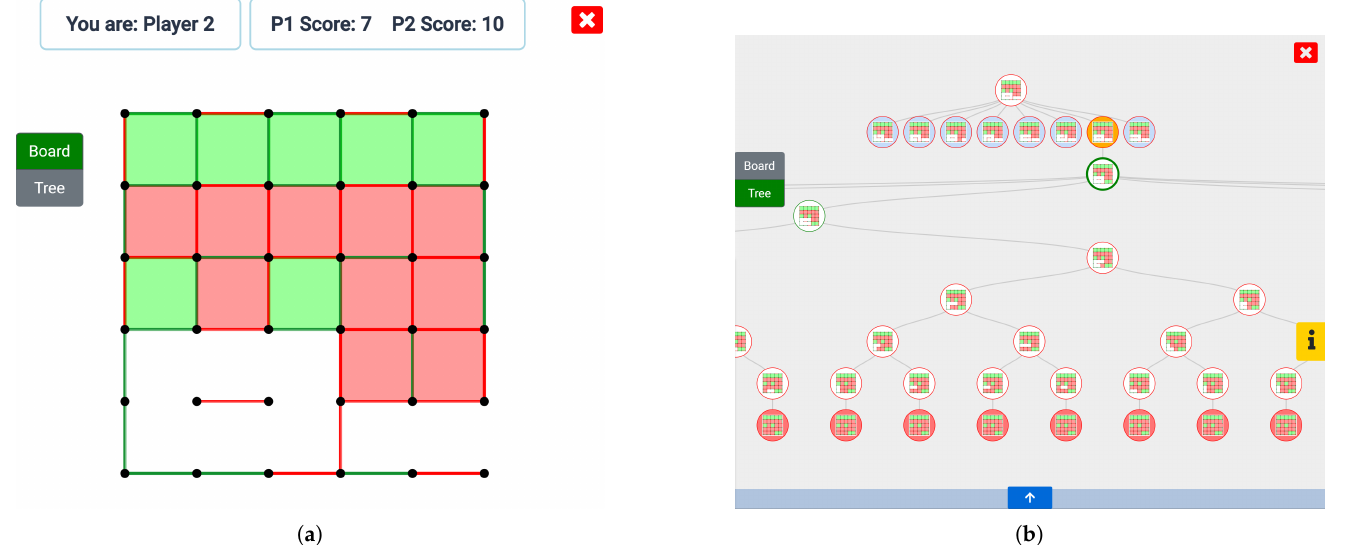
Figure 5. The tool implements two different playing modes: ( a ) an interactive board and ( b ) an interactive tree.